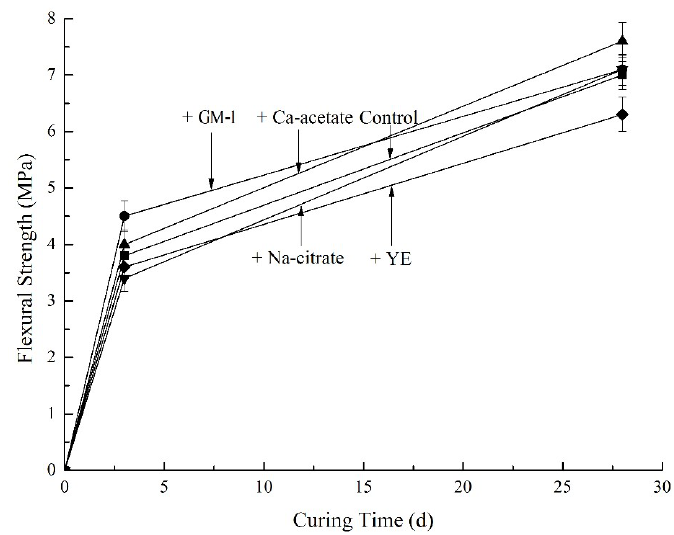
Figure 5. Flexural strength development of mortars.